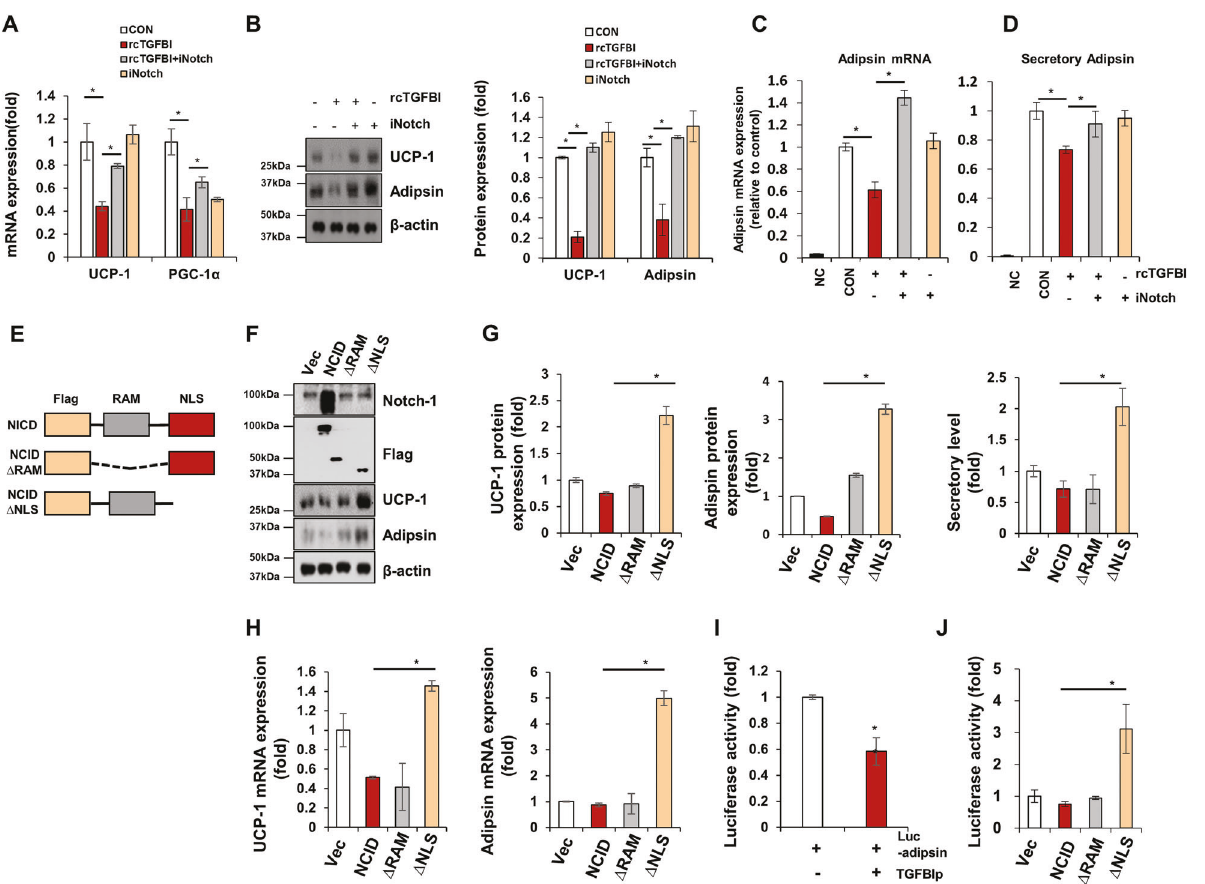
Fig. 8 Notch-1 represses adipsin promoter activity and browning-related protein expression. The 3T3-L1 adipocyte line was treated with Notch-1 inhibitor throughout the differentiation period in the presence or absence of recombinant TGFBI. A,B mRNA and protein expression of the indicated genes. C, D Adipsin mRNA and secretory levels of each indicated group. E The 3T3-L1 adipocytes were transfected with the indicated WT and mutant Notch-1 (RAM and NLS). F-H Protein (F-G) and mRNA (H) expression of the indicated genes in transfected cells. I HEK293 cells were transfected with an Adipsin-Luc vector ( − 430 bp) in the presence or absence of recombinant TGFBI. J HEK293 cells were cotransfected with the indicated Notch-1 construct and Adipsin-Luc vector. Error bars represent the ± SEM. * p < 0.05 by two-sided t